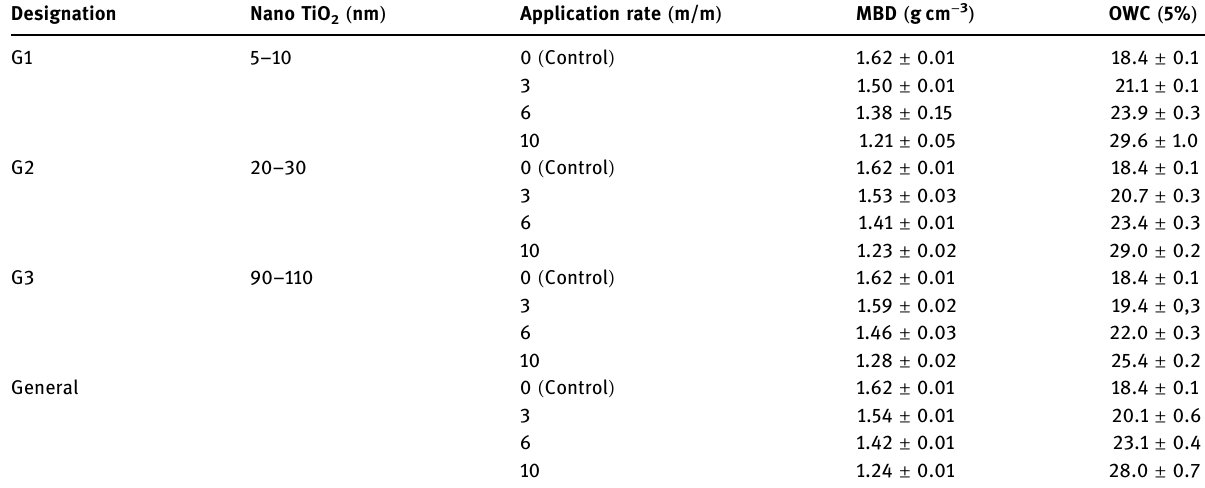
Table 5: E ff ect of nano TiO 2 on maximum dry bulk density ( MBD ) and optimum water content ( OWC ) ( Mean ± SD a